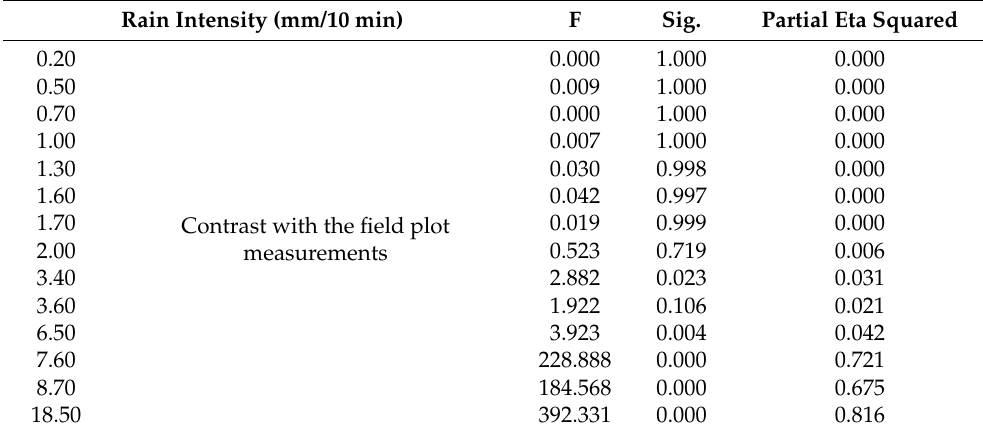
Table 4. Two-way ANOVA results. Summary of comparisons between rainfall intensity (mm/10 min) and the measurements of the different cases (field